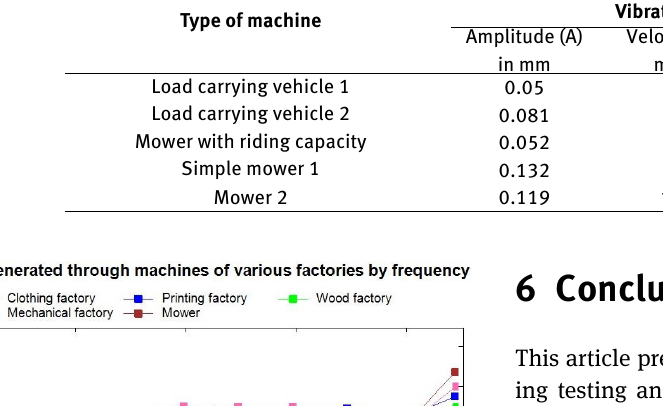
Table 4: Observed values of vibration through various machines Type of machine